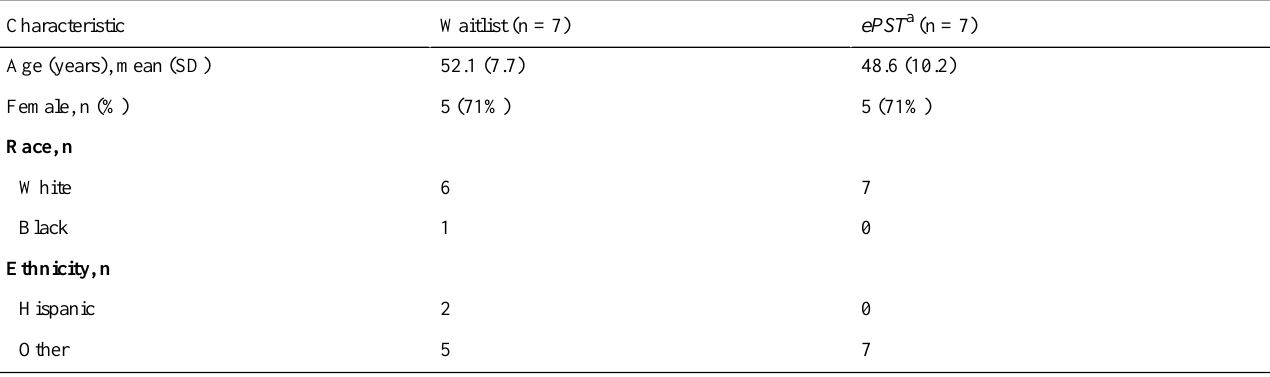
Table 1. Participant